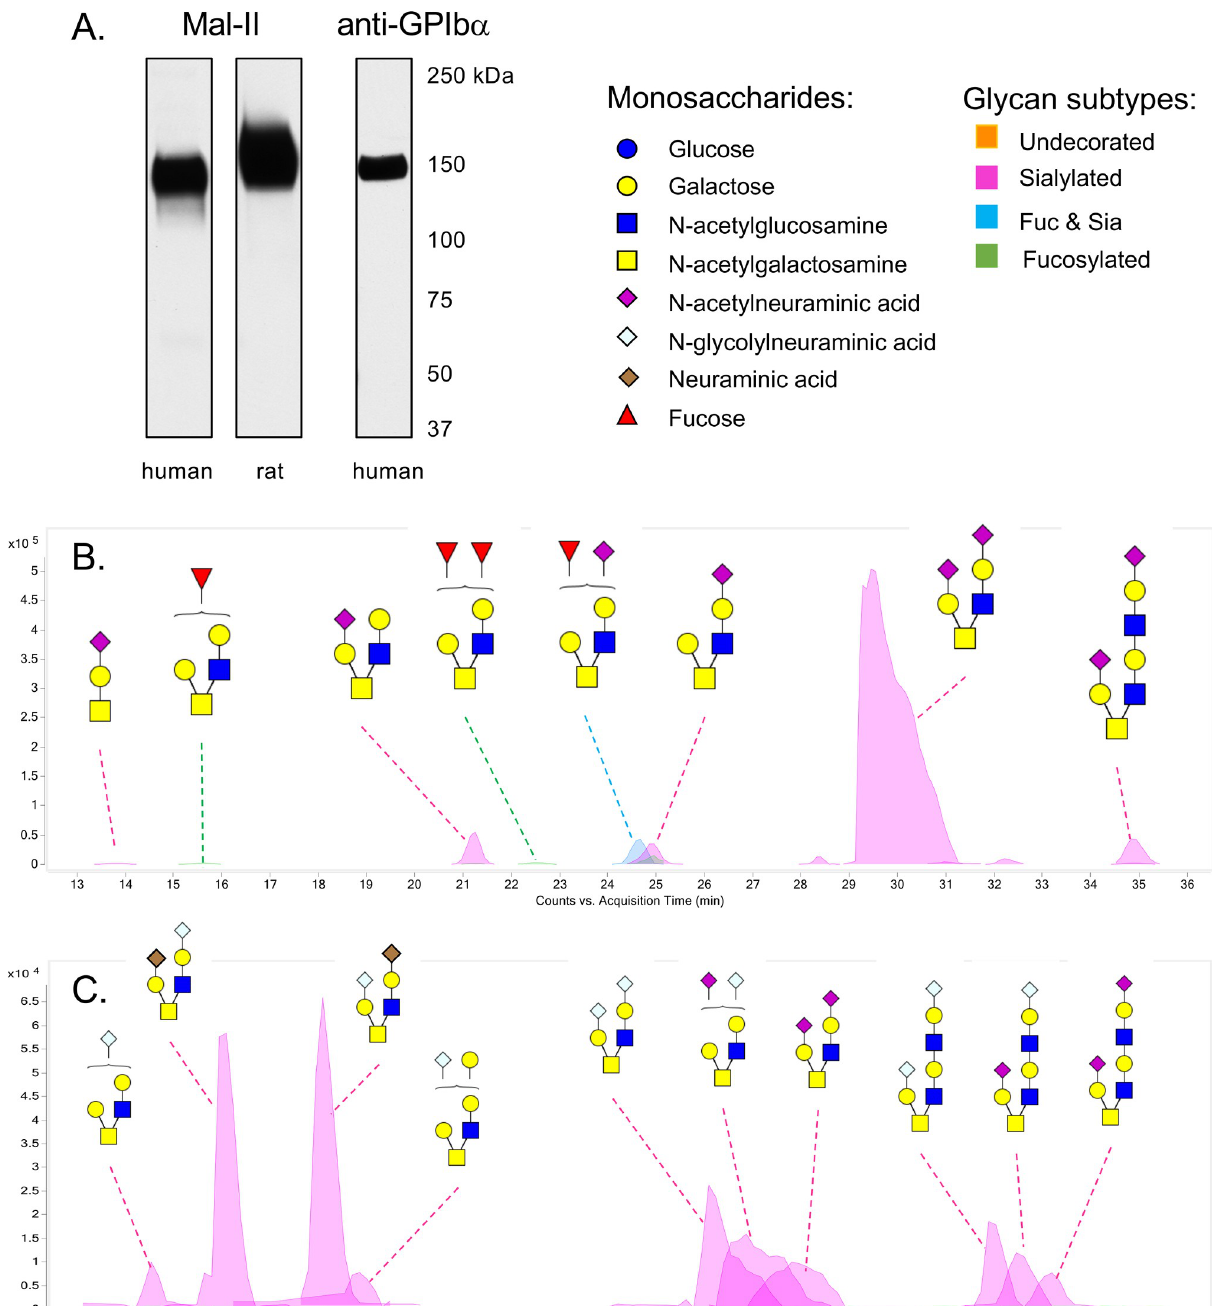
Fig 8. Comparison of human and rat platelet GPIb α O-glycans. A: Western and lectin blot analysis showing GPIb α as the major sialylated glycoprotein in the crude platelet extracts. Lanes contain 2 μ l of the GPIb α preparations. Proteins were separated by electrophoresis on 3–8% polyacrylamide, transferred to nitrocellulose, and then probed as indicated. Mal-II is a lectin commonly used to detect α 2–3 sialic acids, and is specific for sTa and di-sialylated T-antigen [68]. The anti-GPIb α antibody is specific for the human protein. An antibody that recognizes the rat homolog in western blots is not currently available. B: Putative structures of the O-glycans released from the human GPIb α sample. The structures are based on the precise masses and inferred monosaccharide composition (Table 4) in addition to the MS/MS fragmentation patterns. Brackets indicate cases where the position of monosaccharides could not be assigned. Monosaccharide symbols follow the Symbol Nomenclature for Glycans system [67]. C: Putative structures of the O-glycans released from the rat GPIb α sample. The structures are based on the precise masses and inferred monosaccharide composition (Table 5) in addition to MS/MS fragmentation data. Brackets indicate cases where the position of monosaccharides could not be assigned.